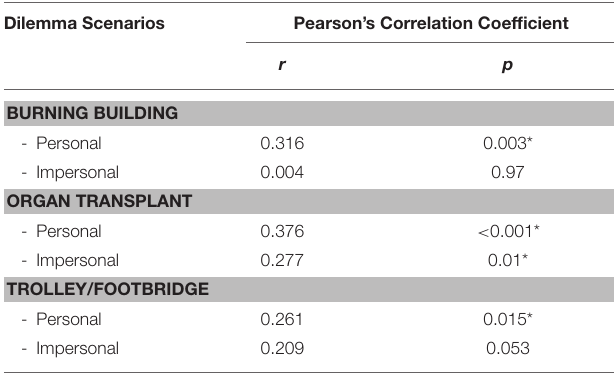
TABLE 4 | Correlation coefficients between utilitarian ratings and self-reported emotional distress intensity within each dilemma scenario across all participants ( N = 86).